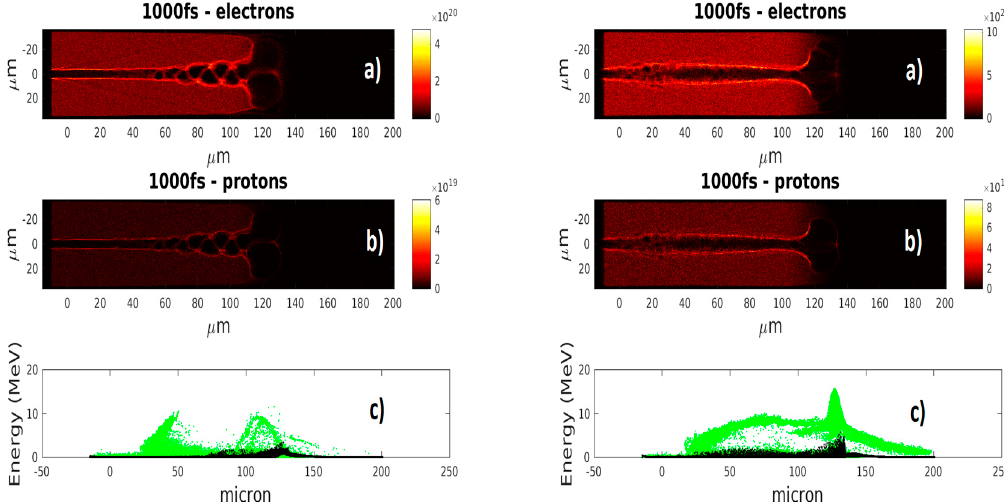
Figure 2. Snapshots of the 2D PICs after 1000 fs from the laser pulse entry in the simulation box of a pure hydrogen plasma at a flat density of 7 × 10 19 e − / cm 3 ( left ) and 2 × 10 20 e − / cm 3 ( right ). The electrons’ (frames a ) and protons’ (frames b ) density distributions are shown for both cases together with the protons’ (black) and electrons’ (green) energies versus the laser propagation direction (frames c ).